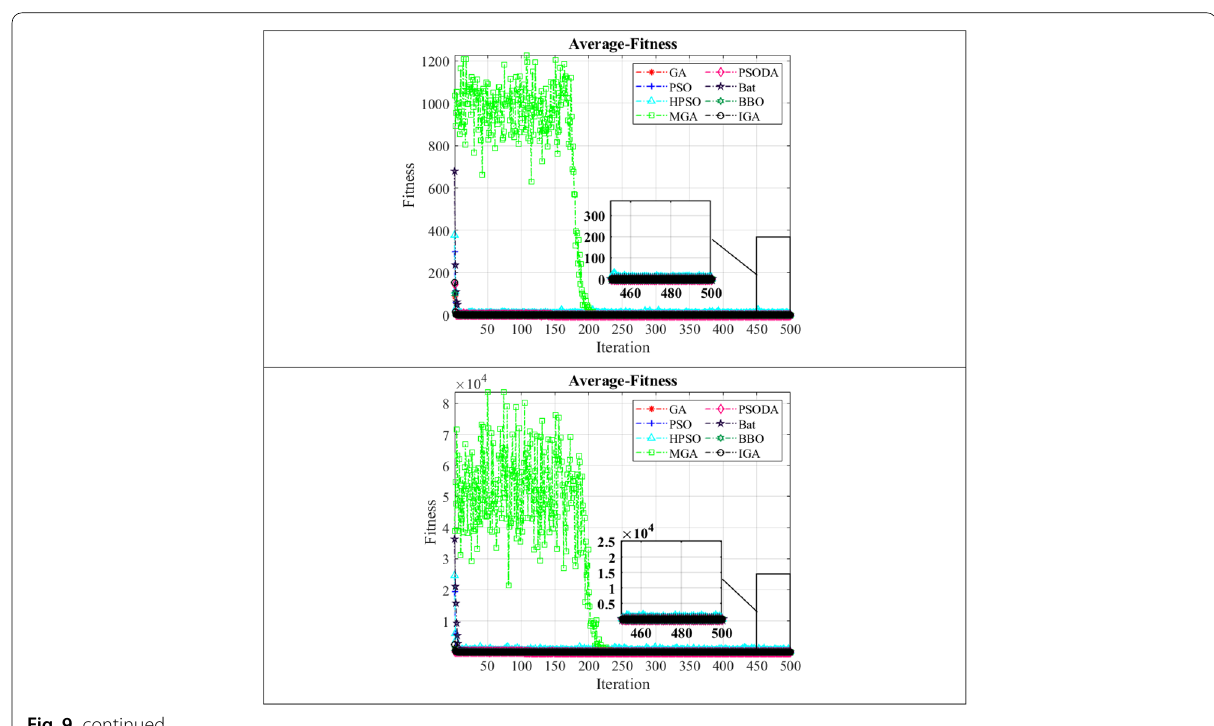
Table 3 Average and standard deviation objective function values obtained by different methods. Test